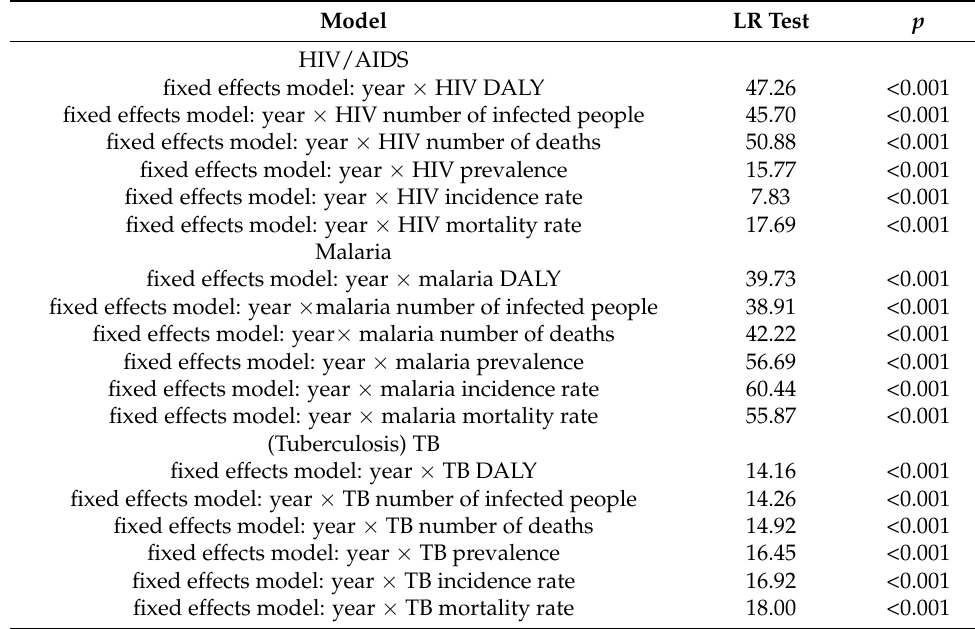
sion line, results of likelihood ratio tests, fixed effects model)